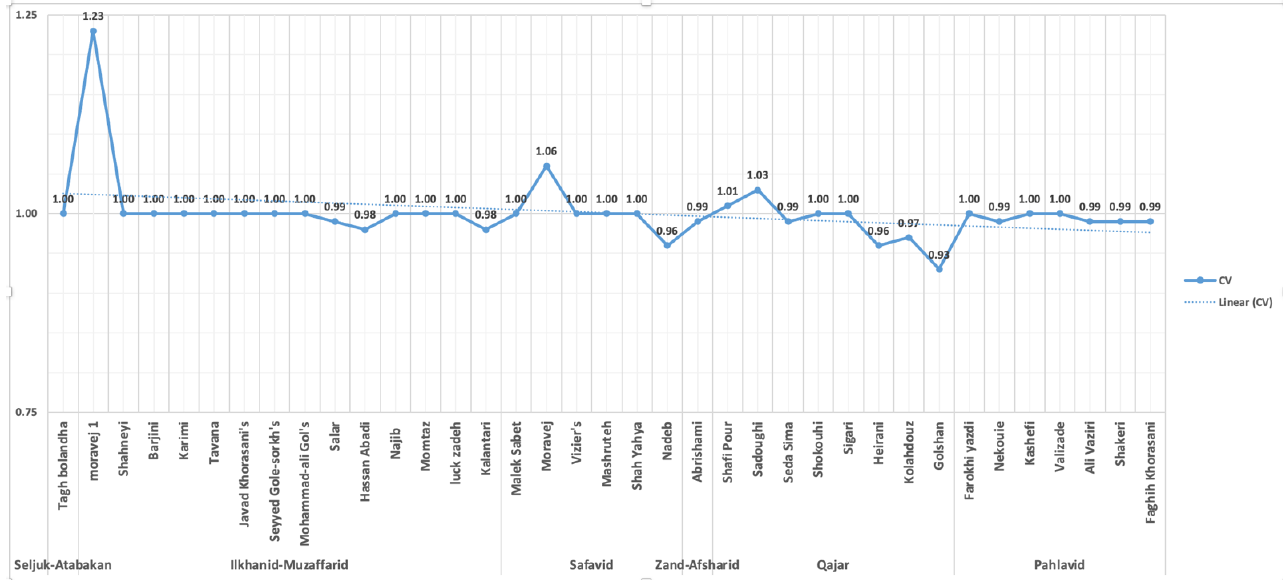
Figure 11. Control Value ( CV ) results and trendlines for the 37 houses, presented chronologically by era.